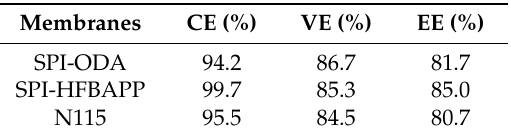
VRFB single cell performance of SPI and N115 membranes at the current density of 100 mA · cm −